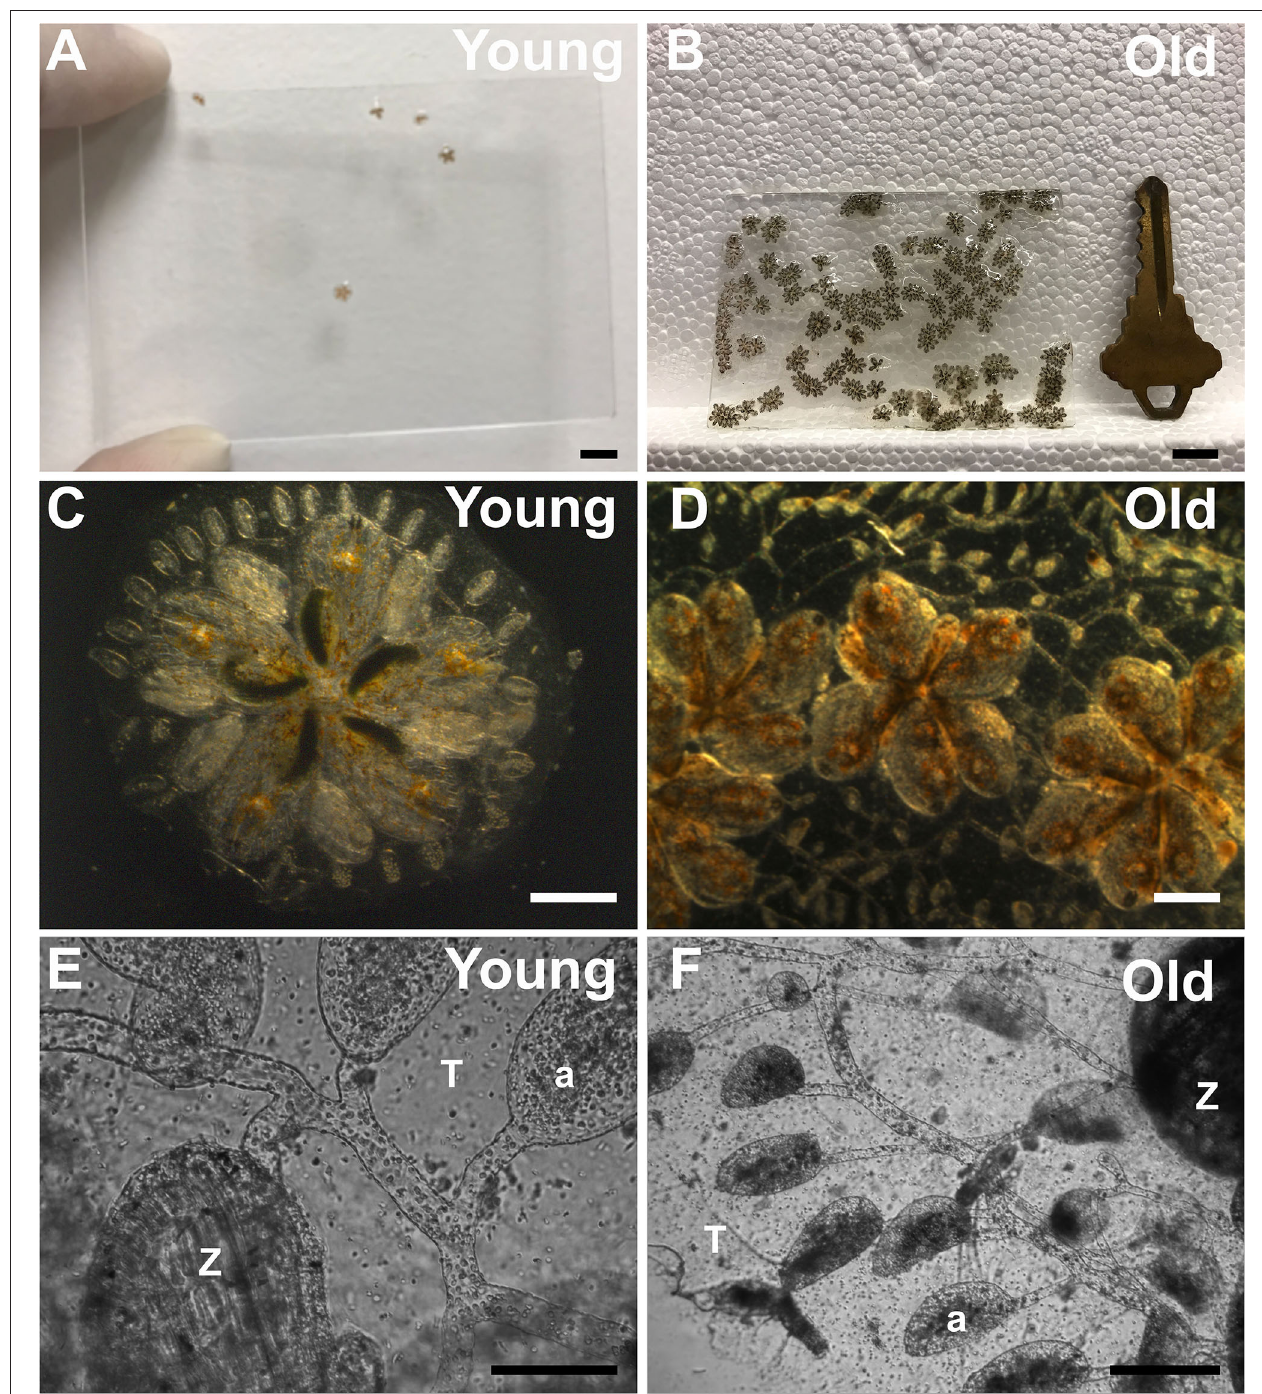
FIGURE 1 | Growth, expansion, and senescence of Botryllus colonies. (A) Young and (B) old Botryllus colonies on 7.6 × 5cm glass slide. (C) Close up of a single young and (D) old Botryllus colony. (E) Close up to the extracorporeal vasculature of a young and (F) old Botryllus colony including zooid (Z) and ampullae (a) and tunic (T). Scale bars: (A,B) = 10mm, (C,D) = 1mm, (E,F) = 50 µ m.